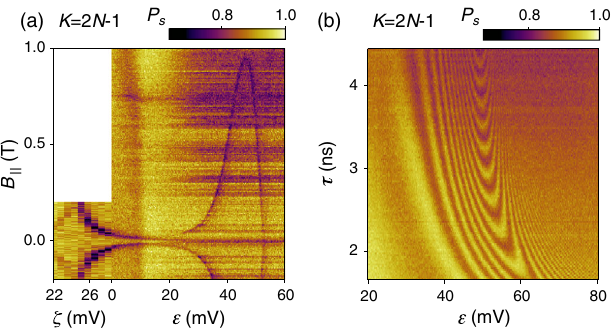
FIG. 8. Leakage spectroscopy (a) and time-resolved measure- ment of exchange oscillations (b) for the multielectron dot occupied by 2 N − 1